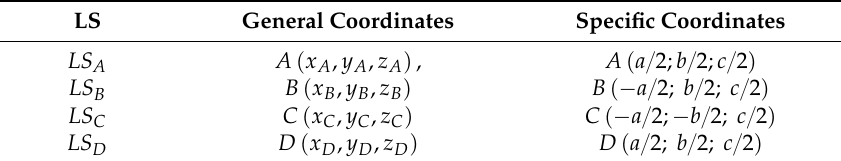
Table 1. Location sensors